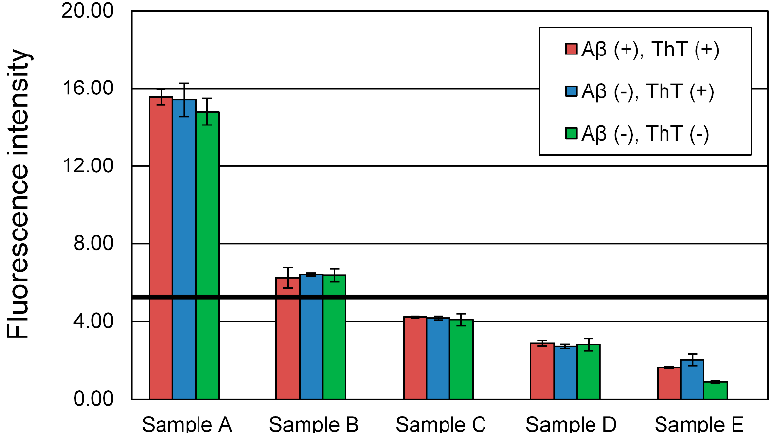
Figure 2. E ff ect of sample solution on ThT fluorescence intensity. A β 42 ( + ), ThT ( + ): A β 42 solution and ThT solution are mixed with sample; A β 42 ( − ), ThT ( + ): only ThT solution is mixed with sample solution; A β 42 ( − ), ThT ( − ): neither A β 42 solution nor ThT solution are mixed and only the sample solution is used. As a negative control, the sample used was an assay bu ff er (10% EtOH, 1 × PBS) under the conditions of A β 42 ( + ) and ThT ( + ) (black line), and its average value of absorbance was 5.28 (A.U.). There is no significant di ff erence between + ThT ( +/ − A β 42 ) and ThT ( − ) condition in all samples (One way ANOVA, p > 0.05).